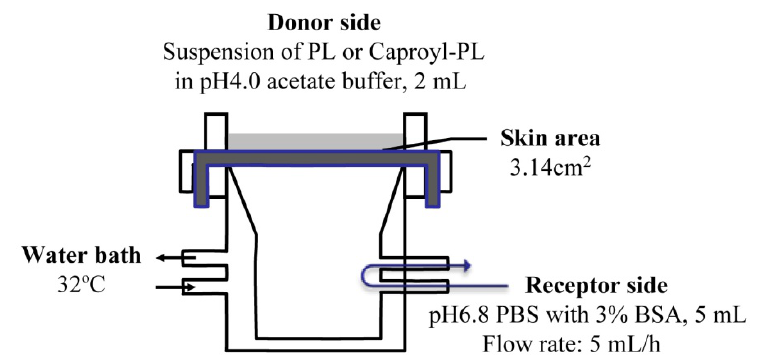
Figure 1. Scheme of transdermal permeation experiment using a flow-through diffusion